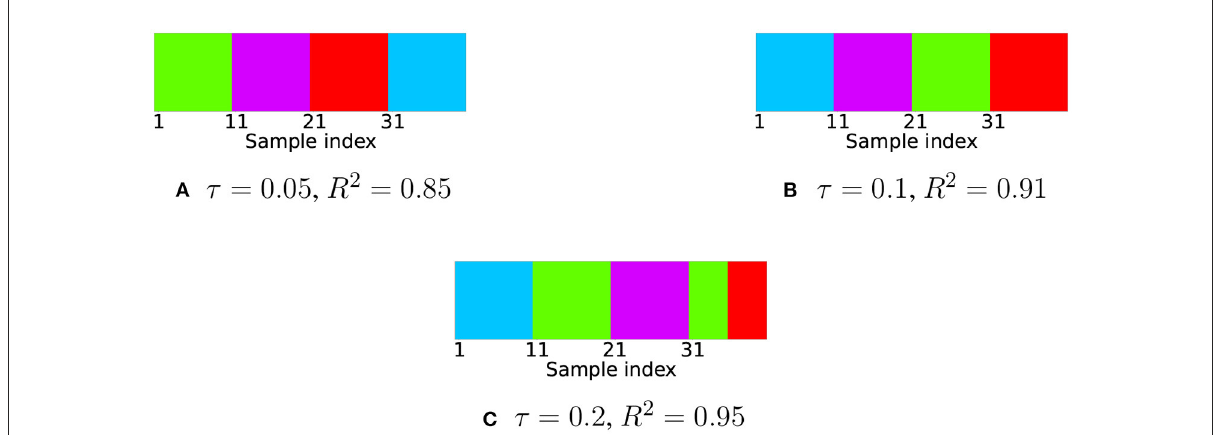
FIGURE2 Clustering results for robotic trajectory data acquired by motion capture. Different colors indicate different labels. There are four ground truth clusters corresponding to sample indices 1–10, 11–20, 21–30, and 31–40. In cases (A,B) all labels identified correctly in the case (C) samples belonging to three out of four primitives are labeled